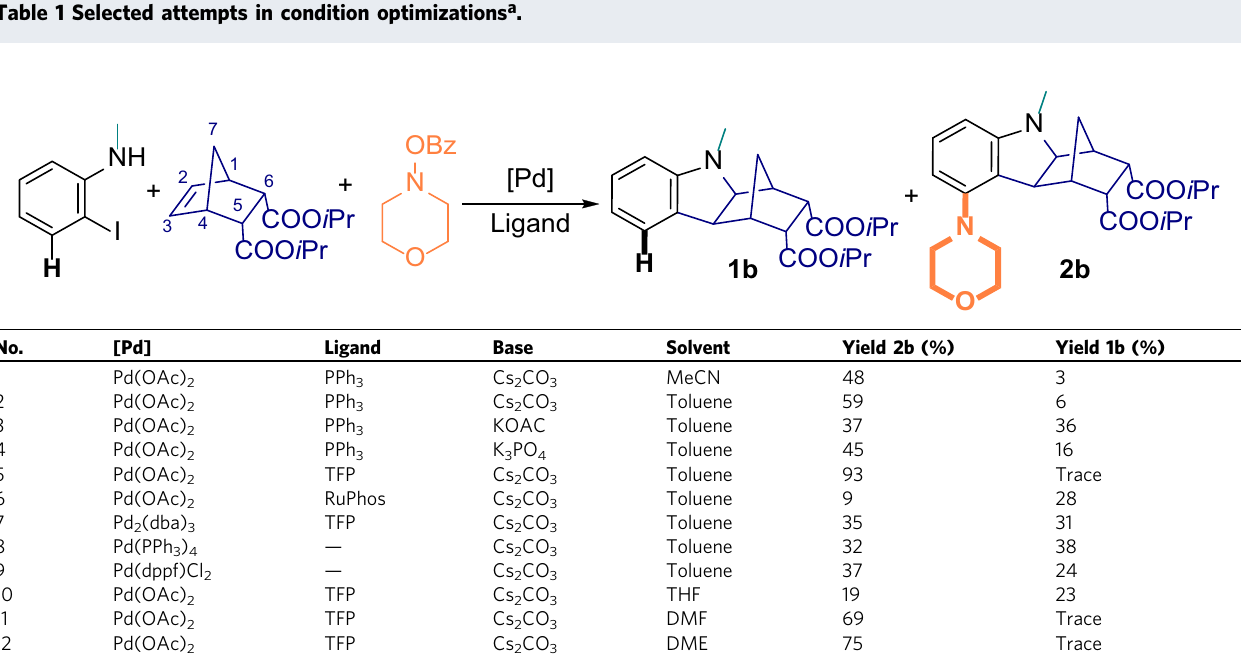
a Unless indicated otherwise, 2-iodo- N -methylaniline (1.0 eq.), NBE-5,6-diCOO i Pr (1.0 eq.), morpholino benzoate (1.3 eq.), Pd (pre)catalyst (5% eq.), ligand (10% eq.), base (2.5 eq.), 100 o C, 12h.